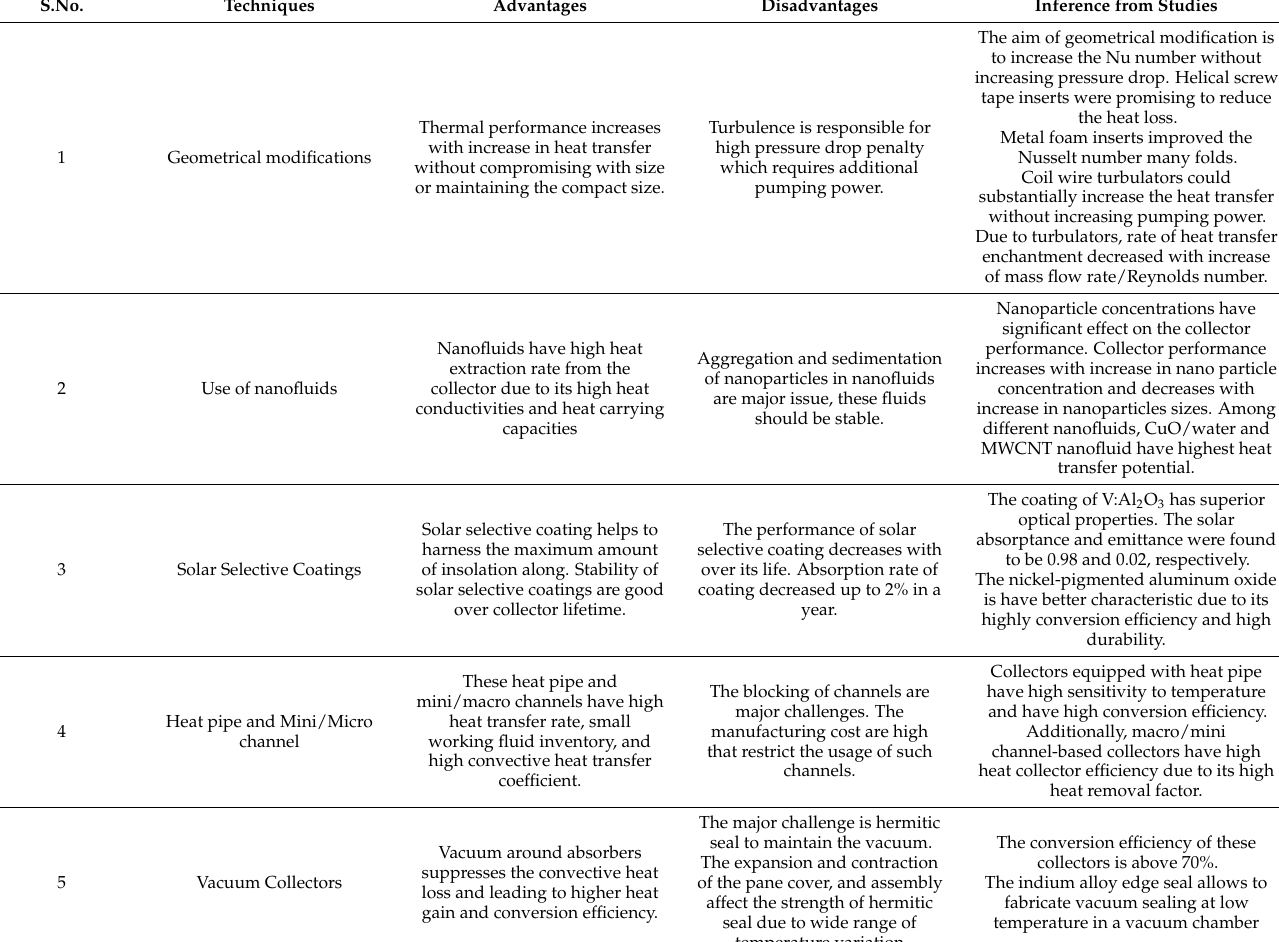
Table 6. Inferences from the various performance improvement